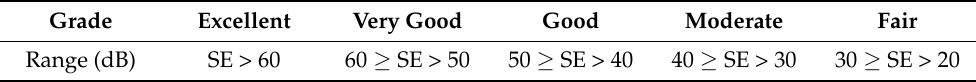
Table 4. Classification of EM SE values based on professional use.